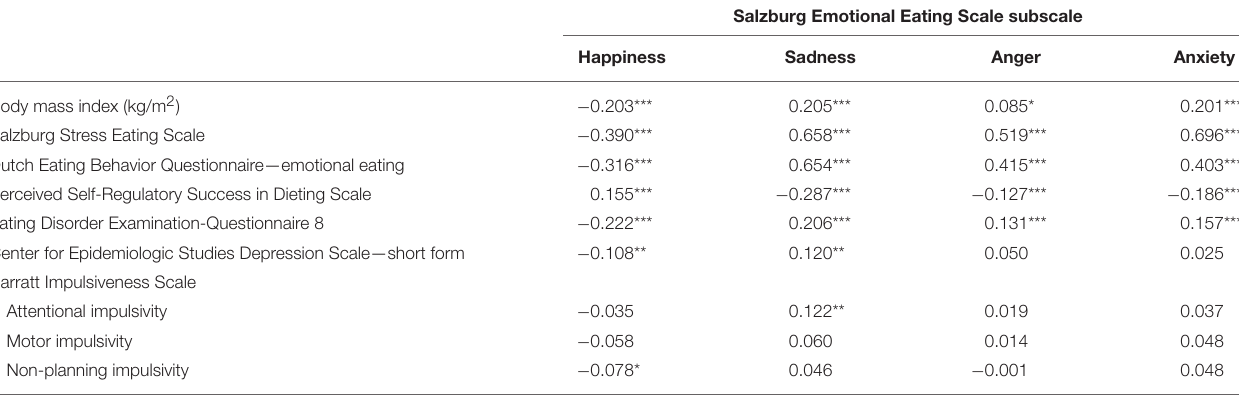
TABLE 4 | Correlations of scores on the Salzburg Emotional Eating Scale and body mass index as well as questionnaire measures in study 2.